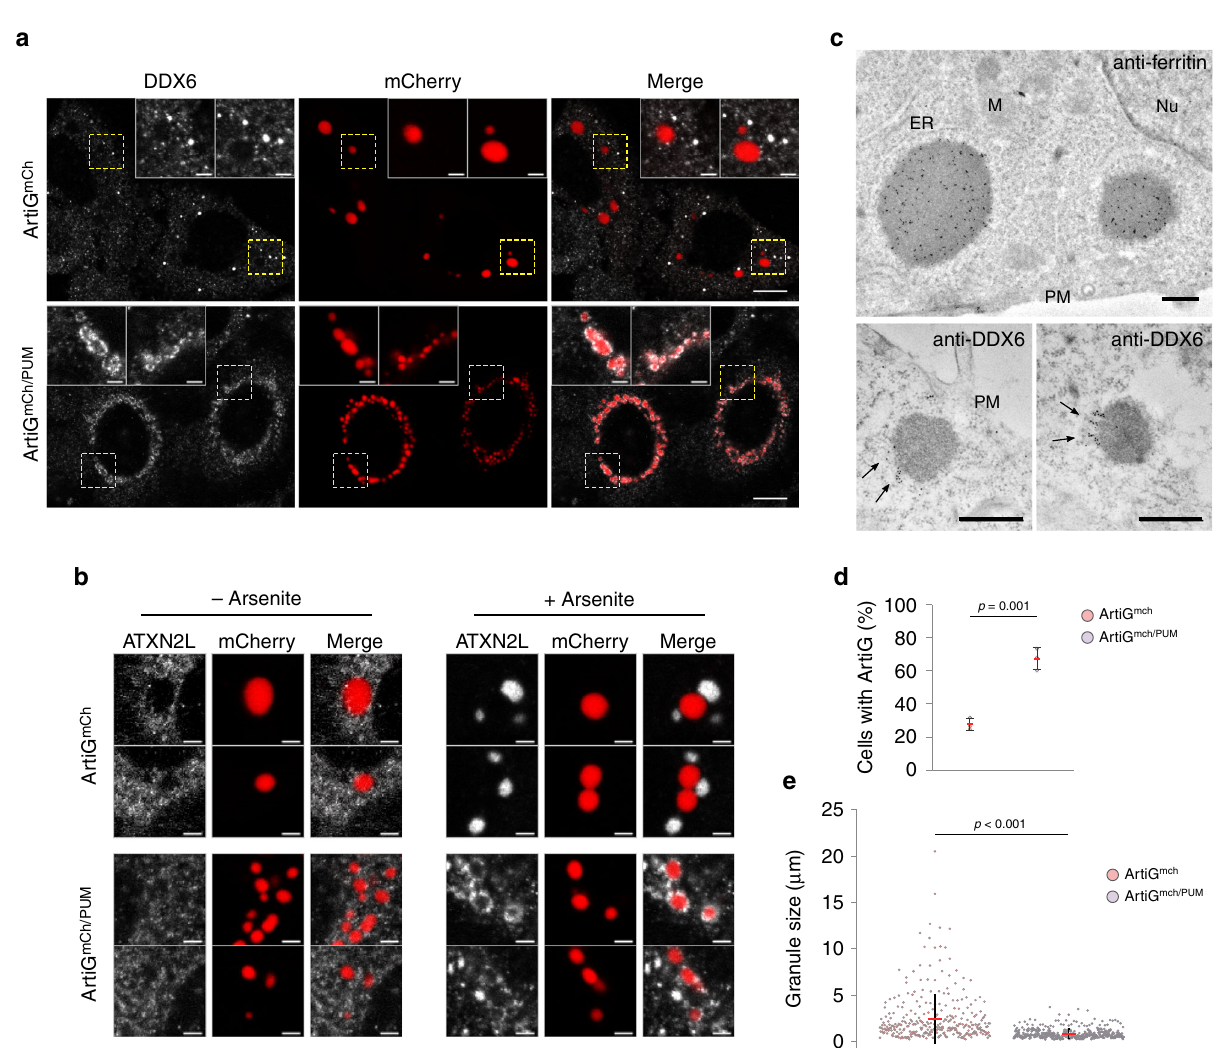
Fig. 4 RNA modi fi es ArtiG PUM composition, nucleation incidence, and morphology. a HeLa cells expressing ArtiG mCh and ArtiG mCh/PUM (red) were fi xed and analyzed by immuno fl uorescence using antibodies recognizing endogenous DDX6 (white). Confocal images. Scale bar, 10 µ m. Zoom, 2 µ m. b HeLa cells expressing ArtiG mCh and ArtiG mCh/PUM (red) were treated or not with arsenite for 30 min, fi xed, and analyzed by immuno fl uorescence using antibodies recognizing endogenous ATXN2L (white). Enlarged regions of the confocal images presented in Supplementary Fig. 4c. Scale bar, 2 µ m. c As indicated, ferritin and endogenous DDX6 were identi fi ed in thin sections of ArtiG mCh/PUM -expressing cells, using a secondary antibody coupled to 10 nm gold particles. Ferritin is concentrated all-over ArtiG mCh/PUM (upper panel), whereas DDX6 accumulates at the edge of the condensates (lower panels, black arrows). Scale bar, 500 nm. ER endoplasmic reticulum, M mitochondrion, Nu nucleus, PM plasma membrane. d Percentage of transfected cells displaying ArtiG condensates 24 h after transfection of mCherry-FFm and PUM.HD-FFm constructs. Data represent the mean ± SD of three independent experiments. e Quanti fi cation of the size distribution of ArtiG mCh and ArtiG mCh/PUM . Dots represent single measurements of ArtiG size and are pooled from three independent experiments. Means and SDs are